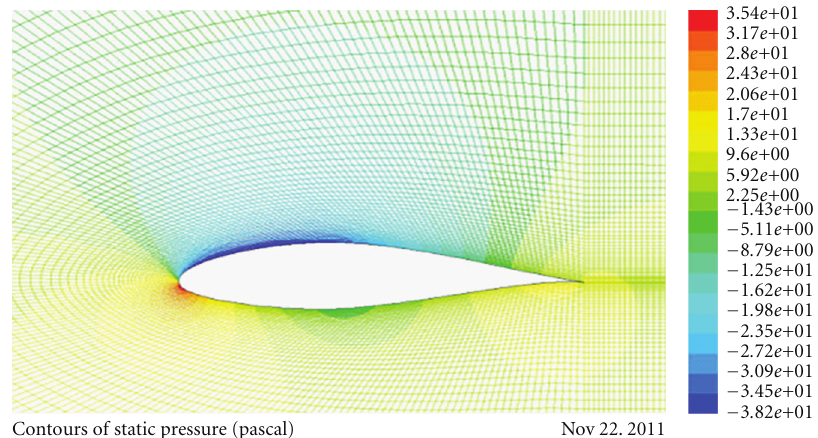
Figure 5: Colour contour of static pressure around NACA 64-421 airfoil at α = 6 and Re = 479,210.